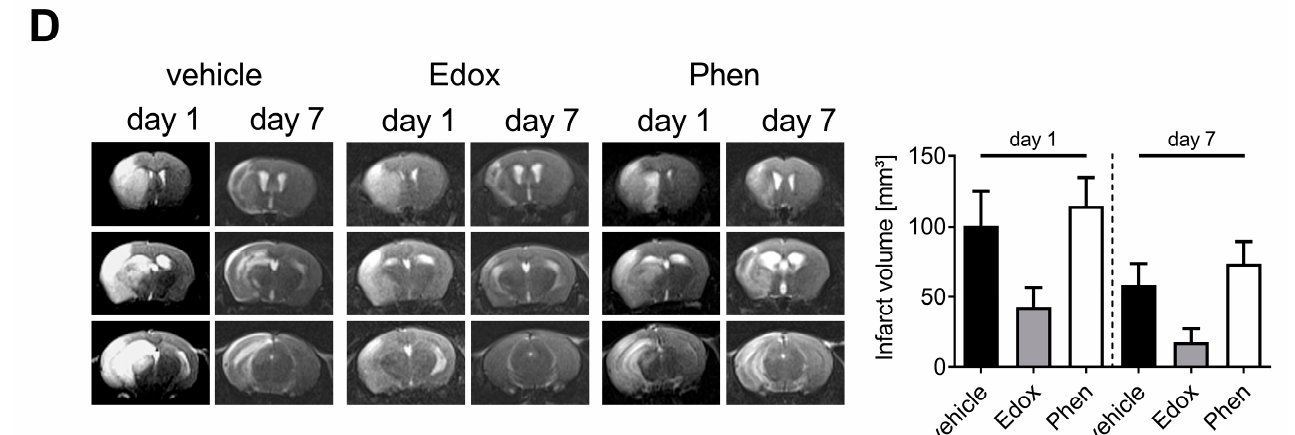
Figure 1. Treatment with edoxaban reduces stroke severity without increasing the risk of intracerebral hemorrhages. ( A ) ( Top ): Definition of the best edoxaban treatment strategy in terms of dose and application time (group I–III) for transient middle cerebral artery occlusion (tMCAO) experiments by measuring plasma edoxaban levels. ( Bottom ): Quantification of edoxaban plasma concentrations of different treatment strategies analyzed by ultra-high-performance liquid chromatography coupled with ultrasensitive tandem mass spectrometer ( n = 3/group). ( B ) ( Top ): Representative 2,3,5-triphenyltetrazolium chloride (TTC) staining of three corresponding coronal brain sections of vehicle-, edoxaban (Edox)-, or phenprocoumon (Phen)-treated mice euthanized 24 h after tMCAO (scale bar = 10 mm). ( Bottom ): The infarcts (white) appear smallest in the edoxaban group, and this could be confirmed by infarct volumetry ( n = 9). ( C ) Bederson score ( left ) and grip test ( right ) at day 1 after tMCAO in the three mouse groups indicated above ( n = 9). ( D ) ( Left ): Serial coronal T2-weighted gradient echo magnetic resonance images (MRI) show extensive hyperintense (bright) ischemic lesions in vehicle- and phenprocoumon-treated mice on day 1 and day 7 after tMCAO, whereas the infarcts were smaller with edoxaban treatment. One representative imaging panel per group is depicted. ( Right ): MRI-based infarct volumetry ( n = 3–5). * p < 0.05, *** p < 0.001.